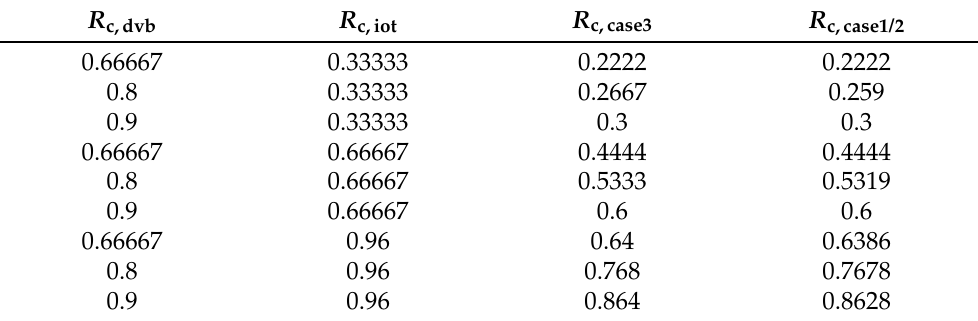
Table 3. NB-IoT and DVB-S2(X) equivalent code rates for the relaying architectures under analysis. R c,dvb R c,iot